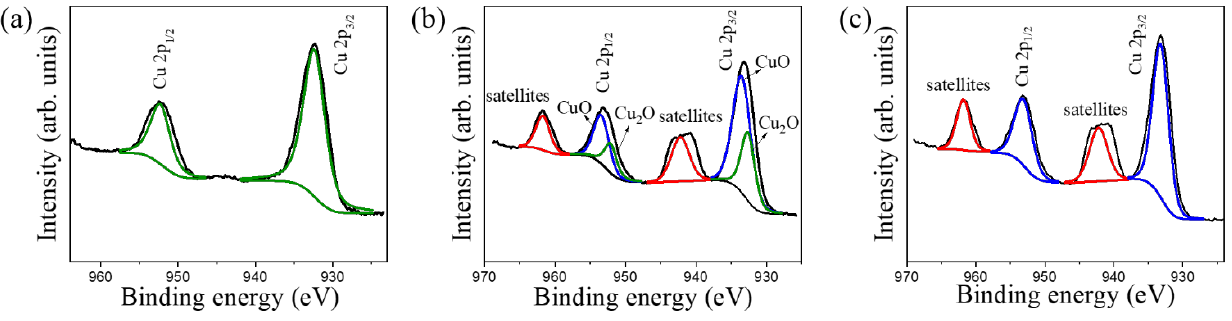
Figure 6. High-resolution XPS Cu 2p spectra: ( a ) TC200, ( b ) TC350, and ( c ) TC400.